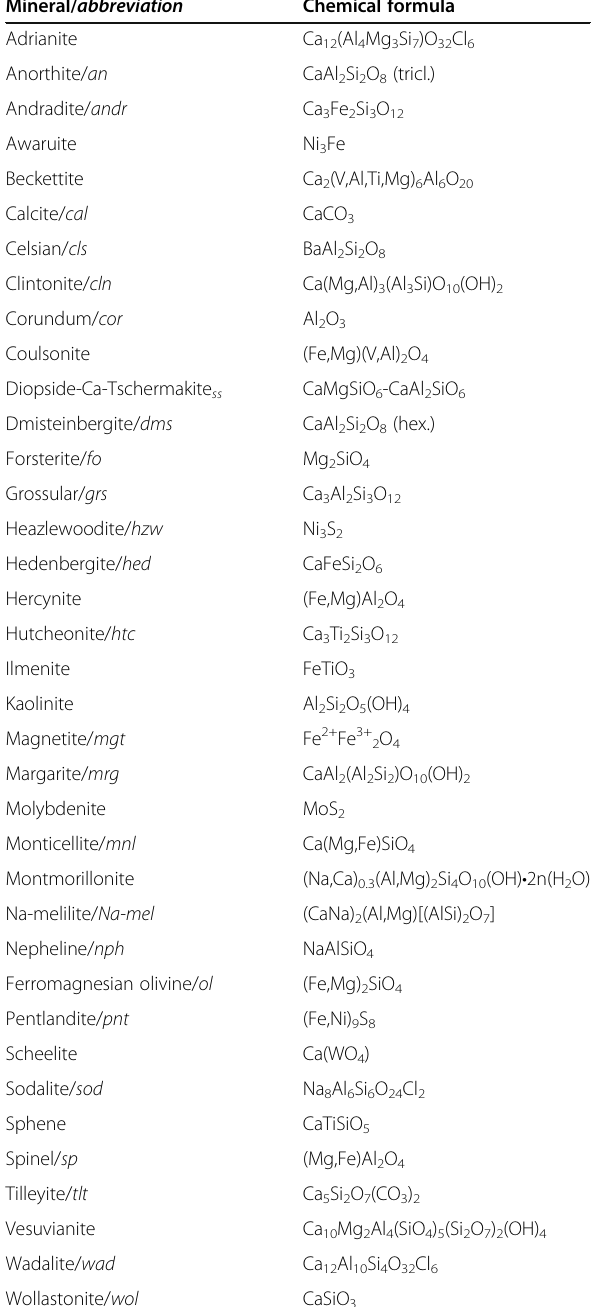
Table 2 A partial list of secondary minerals in the Allende coarse-grained igneous CAIs, their formulae, and abbreviations used in the